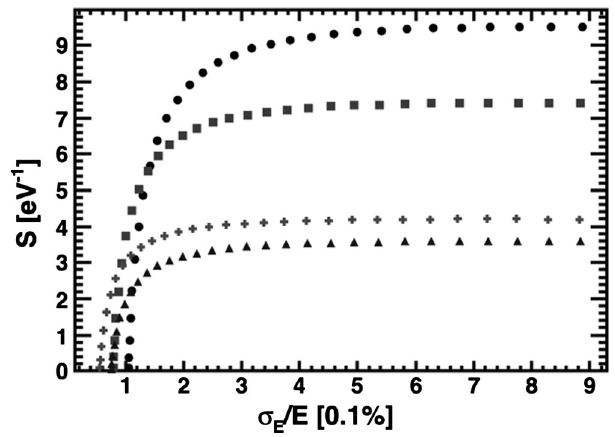
FIG. 9. The spectral density vs the ICS bandwidth for a laser pulse energy of U ¼ 25 mJ, (black dots) σ t;l ¼ 0 . 5 ps and σ x;l ¼ σ ¼ 7 . 5 μ m, (gray squares) σ y;l 7 . 5 μ m, (black triangles) σ and (gray crosses) σ t;l ¼ 1 . 25 ps and σ x;l ¼ σ y;l ¼ 12 . 5 μ m.